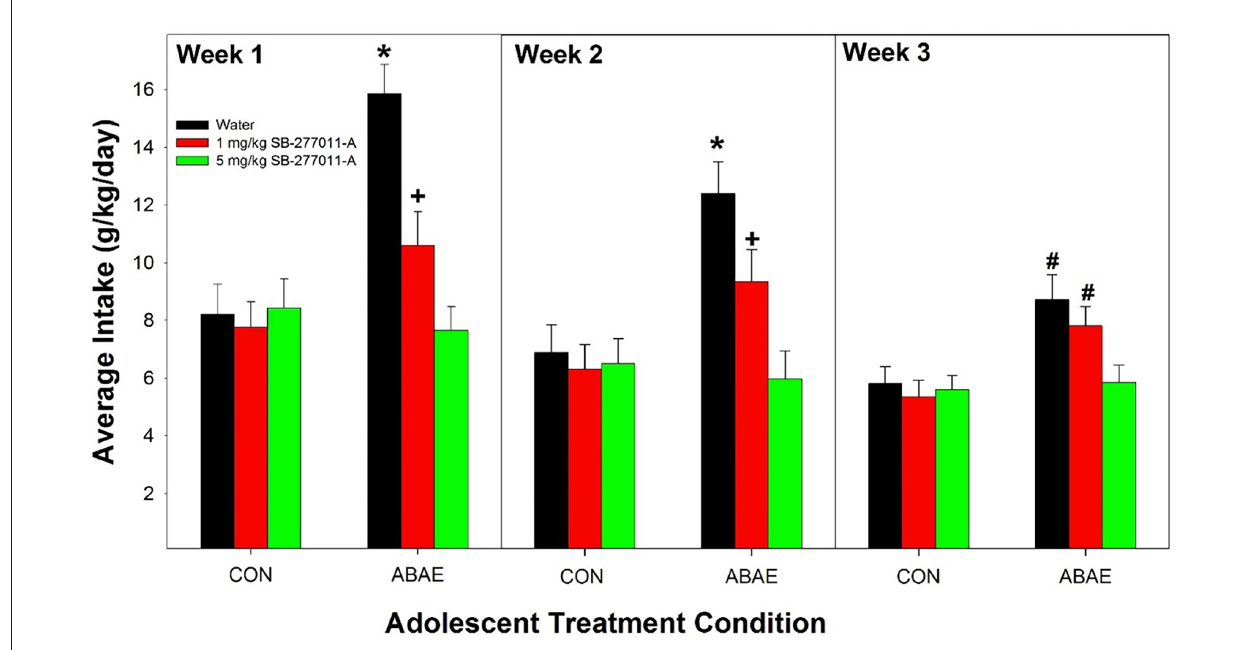
FIGURE3 Depicts the average alcohol intake in female P rats administered the α 7 NAM SB-277011-A 2 h before ABAE treatment during adolescence on the adult consumption of EtOH. *indicates EtOH consumption in water-ABAE rats >1 mg and 5 mg/kg SB rats. + indicates 1 mg/kg >5 mg/kg SB rats. # indicates water-ABAE and 1 mg/kg SB >5 mg/kg SB